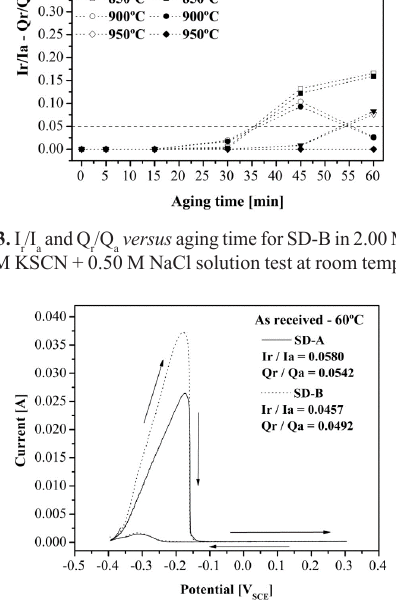
Figure 2. I + 0.01 M KSCN + 0.50 M NaCl solution test at room temperature.